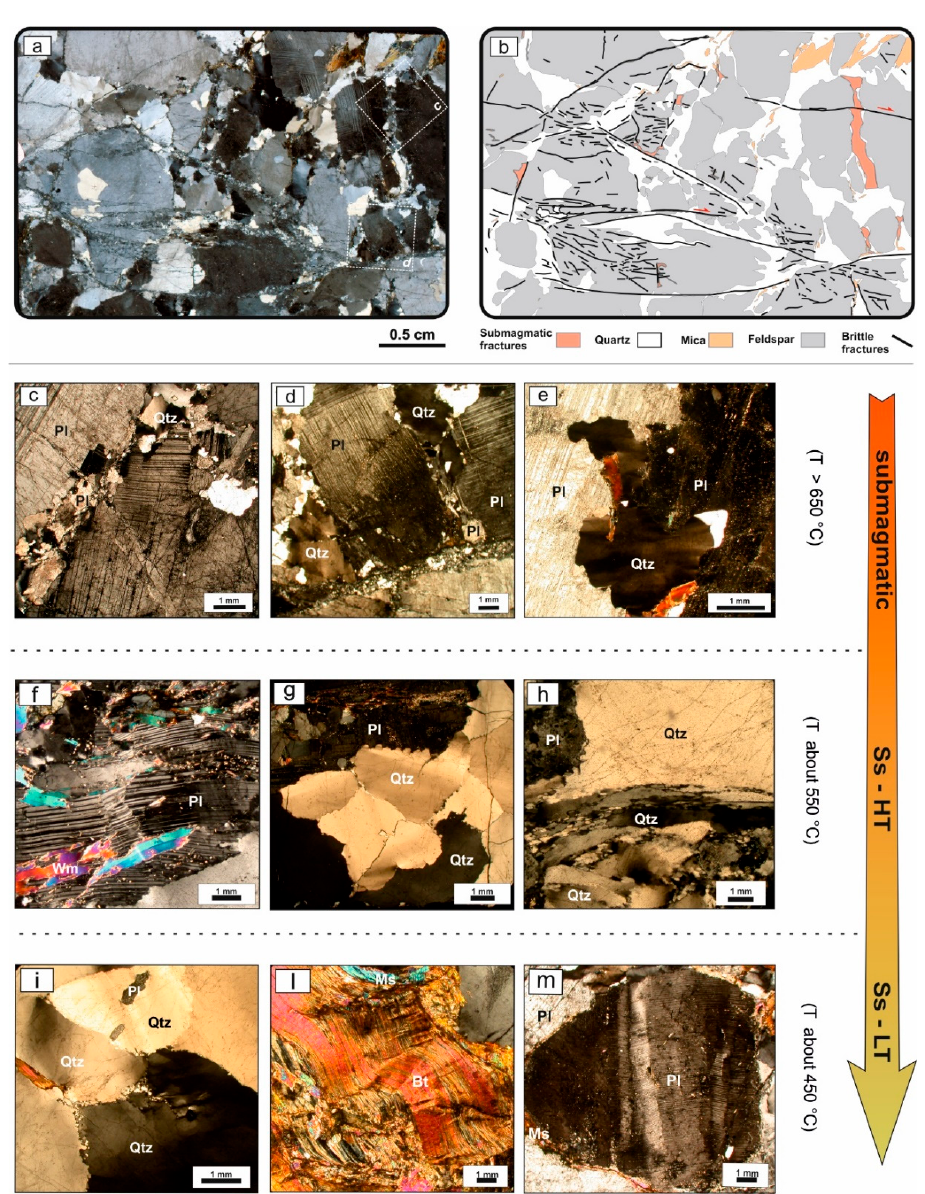
Figure 7. Shear-related deformation microstructures developed in the trondhjemites from sub-magmatic to low-temperature subsolidus conditions (Ss-HT = Solid state High Temperature; Ss-LT = Solid state Low Temperature) (crossed polars). Abbreviations: Pl, plagioclase; Qtz, quartz; Kfs, K-feldspar; Wm, white mica; Bt, biotite. ( a ) thin section scan of a representative trondhjemite specimen; ( b ) microtectonic sketch drawing of ( a ); ( c ) submagmatic fracture (please see ‘a’ for location within the thin section) filled by quartz dislocating a large feldspar grain showing internal plastic deformation given by twinning; ( d ) gently left-dipping cataclastic band crosscutting sub-vertical submagmatic vein (please see ‘a’ for location in the thin section); ( e ) chessboard pattern in quartz grain in contact with plagioclase showing lobate grain boundaries; ( f ) white mica and plagioclase grains intensely deformed; ( g ) recrystallization subgrains (SGR) and bulging (BLG) at the edge of a stretched quartz grain showing undulose extinction; ( h ) ribbon-like quartz showing undulose extinction; ( i ) quartz subgrains at the boundaries of intensely deformed large grains with undulose extinction; ( l ) pervasive kink bands in micaceous layers; ( m ) twins planes bent in plagioclase.